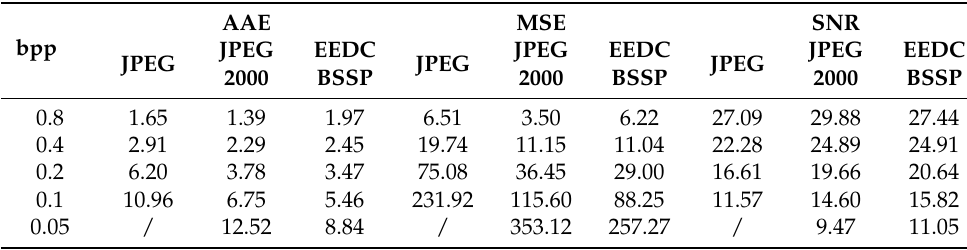
Table 9. Results of the AAE, MSE, and SNR metrics for image horse . bpp